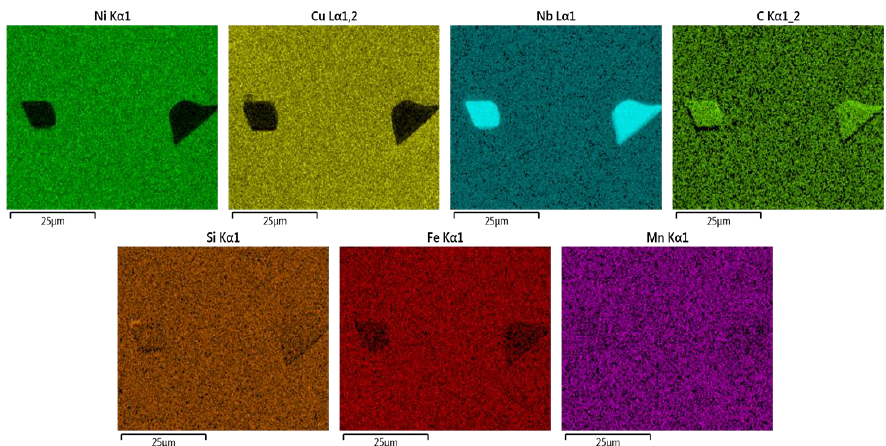
Figure 7. EDS mapping showing coarse NbC particles in an as-cast sample.